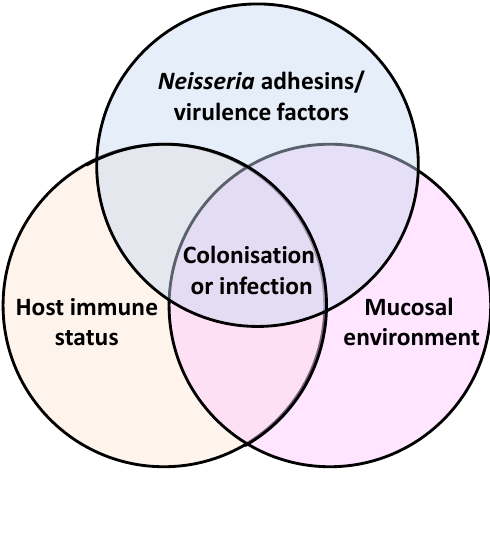
Figure 3. The interplay between Neisseria adhesins/virulence factors, host immune status and mucosal environment determine host colonisation or